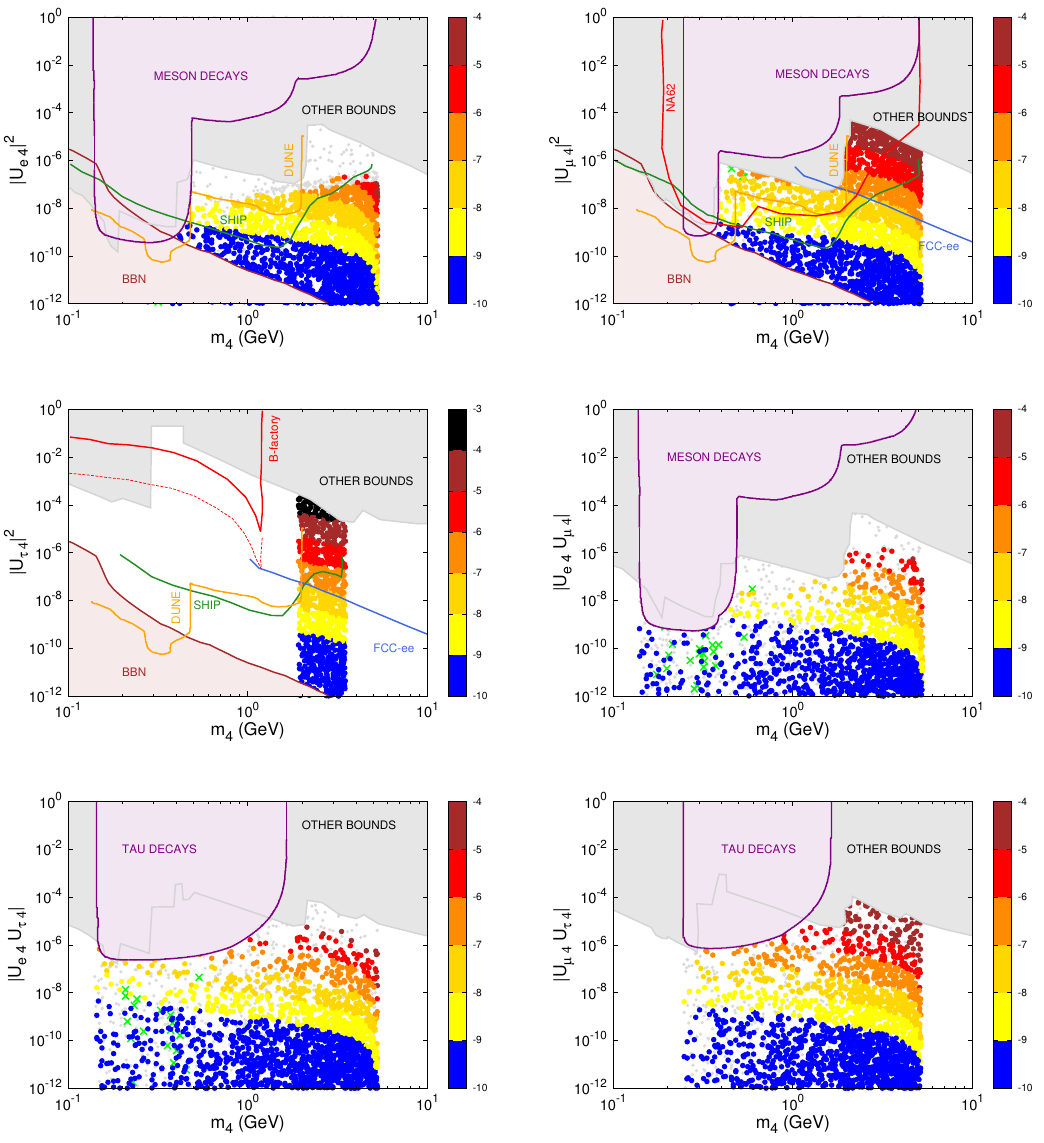
Figure 20 . Same as (cid:12)gure 19 but without excluding the excessively long-lived sterile